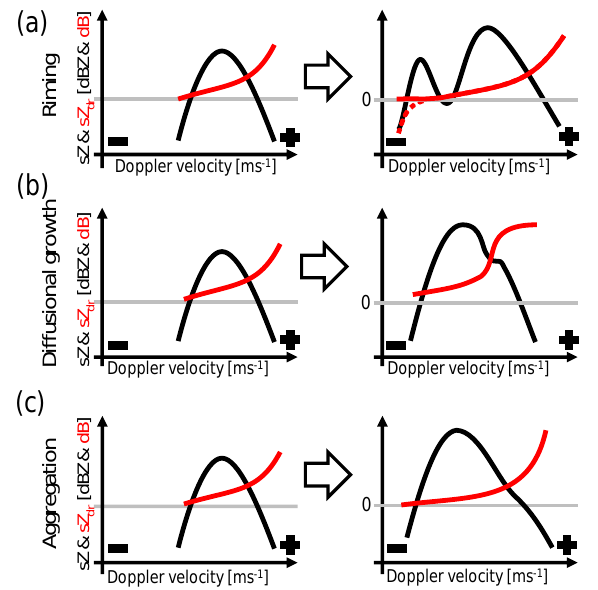
Figure 3. Sketch of signature of (a) riming, (b) diffusional growth and aggregation, and (c) aggregation of ice particles and their corre- sponding changes in the Doppler spectra sZ (black lines) and spec- tral differential reflectivity sZ DR (red lines). All sketches represent theoretical dependencies, the gray line indicates 0dB for the sZ DR values. The Doppler velocity values are relative values (left: minus sign: large negative Doppler velocities; right: plus sign; very small or positive Doppler velocities; negative Doppler velocities indicate movements towards the radar). Conceptional sketches are based on spectral simulations of Spek et al. (2008), Dufournet and Russchen- berg (2011), and Oue et al.